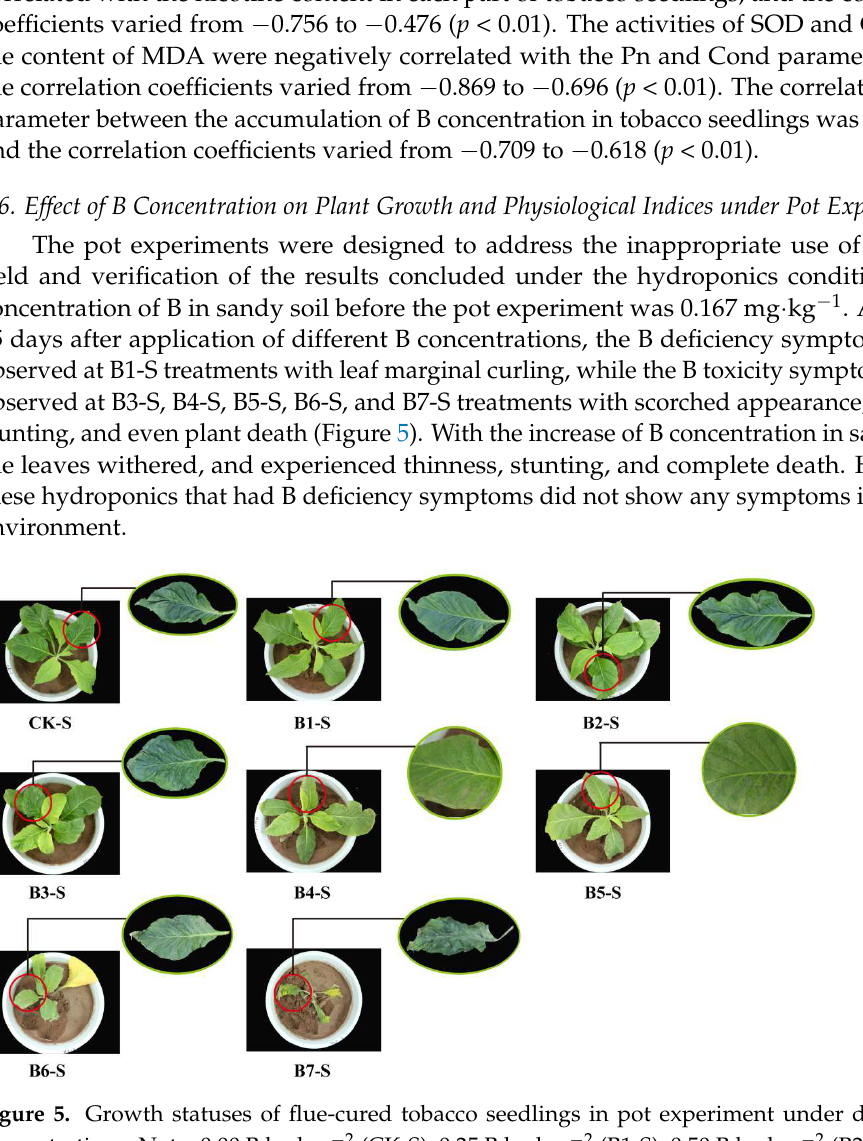
(B4-S), 52.05% (B6-S), and 29.89% (B7-S), respectively (Figure 6C).